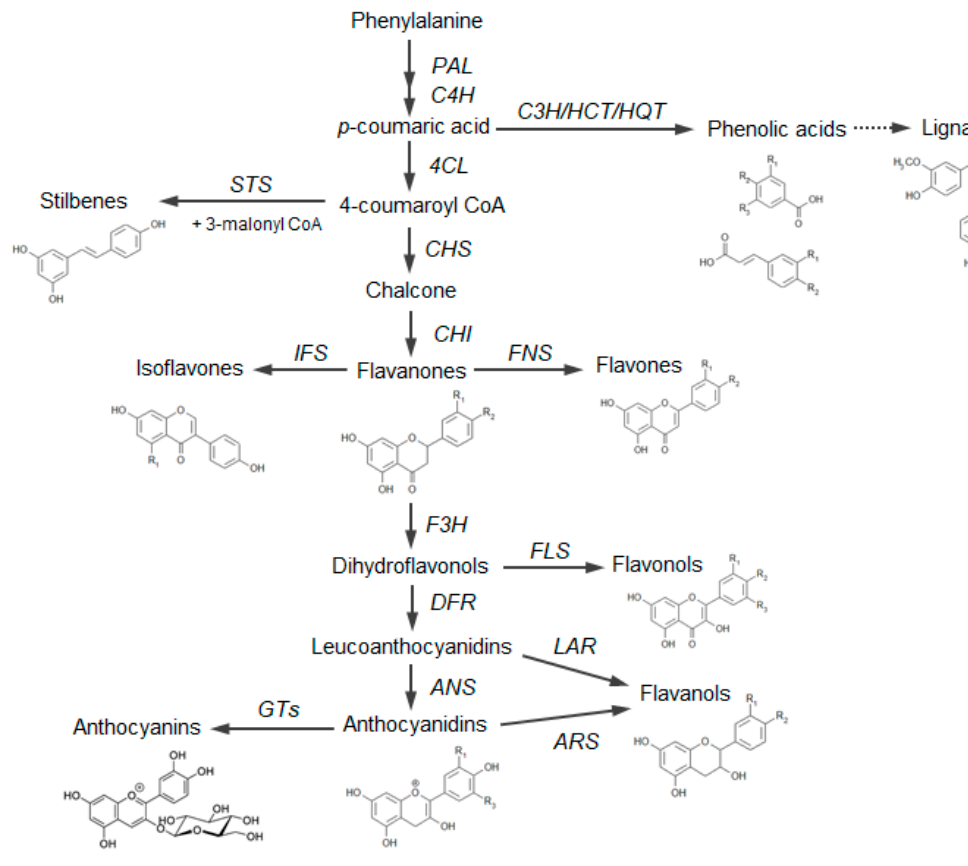
Figure 1. Schematic representation of the general polyphenol biosynthetic pathway, with the main classes of polyphenols. PAL, Phenylalanine ammonia lyase; C4H, cinnamic acid 4-hydroxylase; C3H,